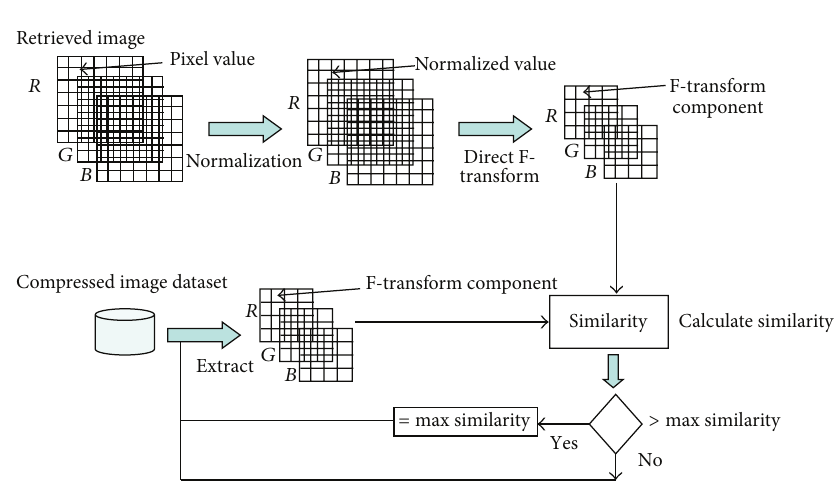
Figure 1: The preprocessing phase.